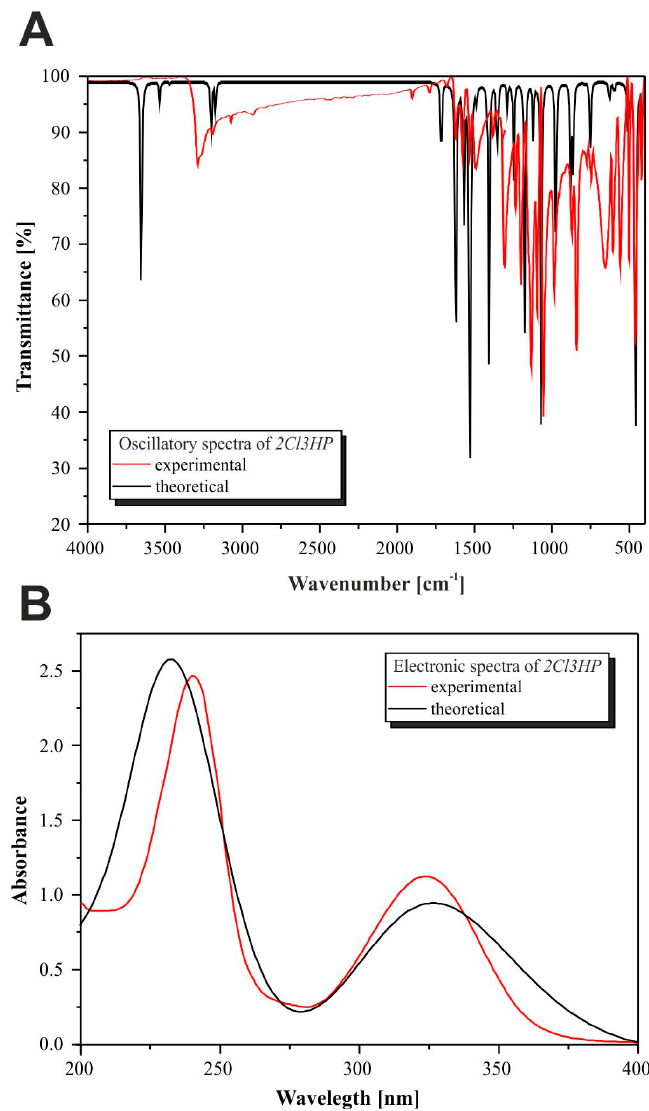
Figure 4. ( A ) Experimental IR spectra—red line, and for comparison computed at B3LYP/6 ‐ 311+G** in vacuo—black line. ( B ) Experimental UV ‐ Vis spectra—red line, and for comparison computed at TD ‐ DFT/B3LYP/6 ‐ 311+G** in vacuo.